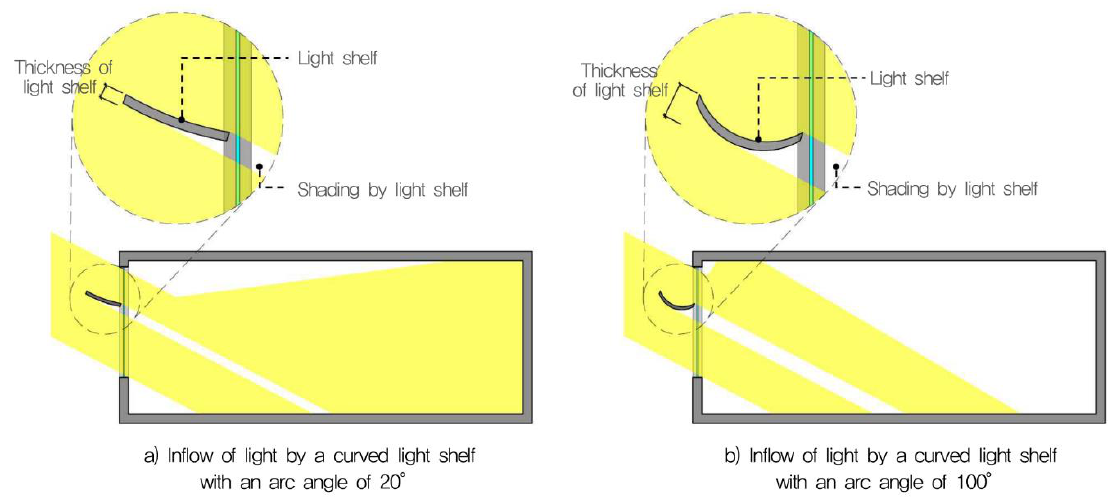
Figure 17. Inflow of light versus the light shelf arc angle during winter.